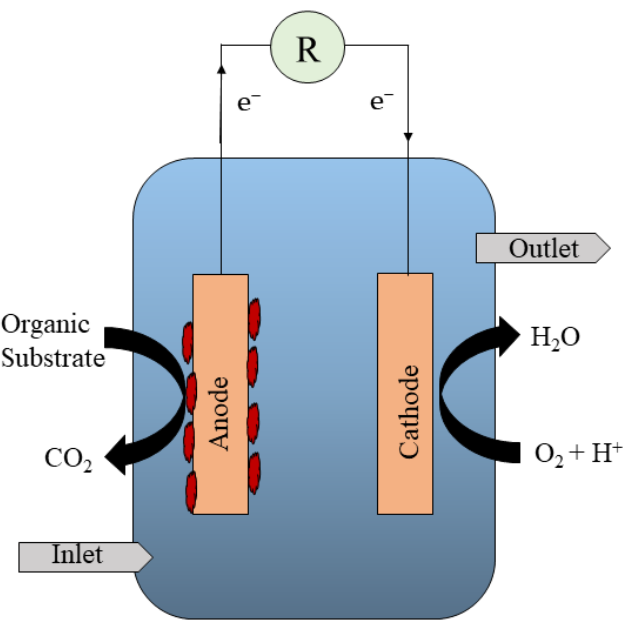
Figure 3. Representation of a typical MFC-integrated MBR reactor.